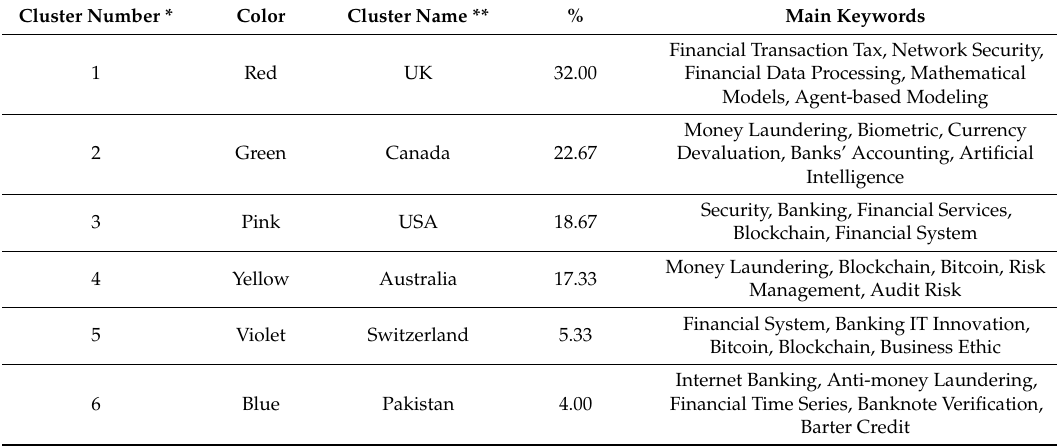
Table 6. Clusters of countries and keywords